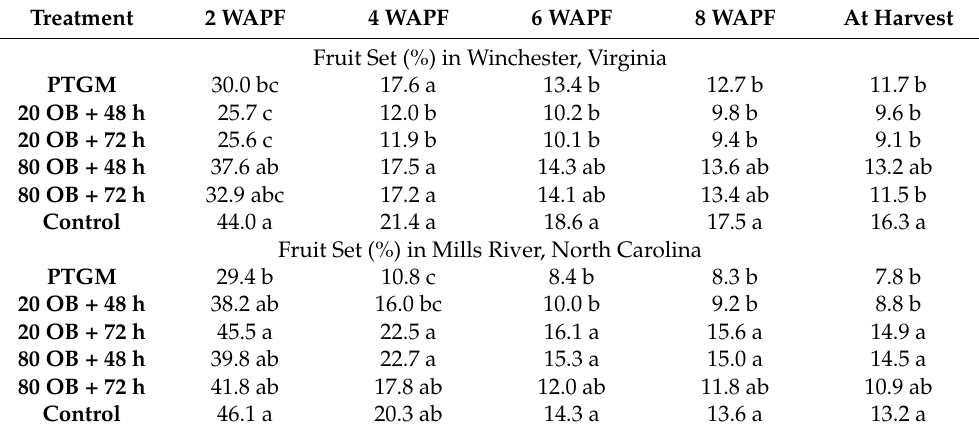
Table 2. Treatment effect on fruit set (%) of ‘Gala’ apples. z